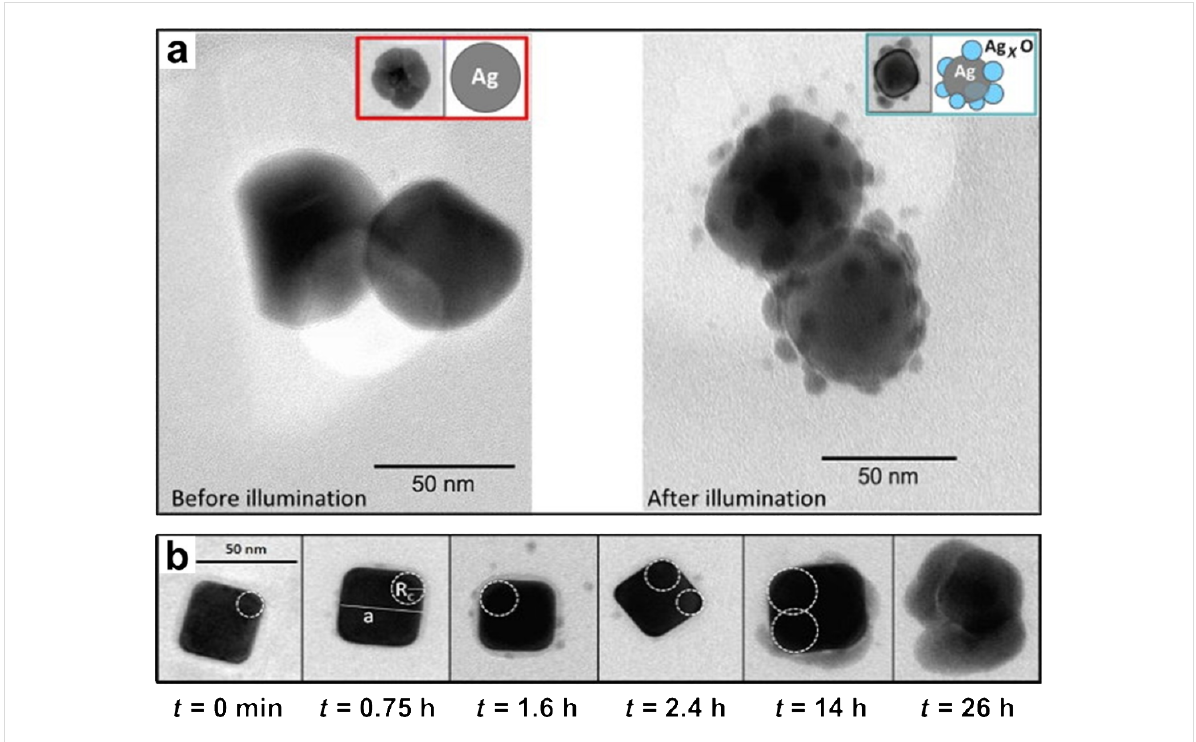
Figure 4: (a) Comparative TEM micrographs of spherical AgNPs before (left) and after (right) light irradiation. The formation of small NPs (Ag x O) after light irradiation is indicative of photo-oxidation. (b) TEM micrographs representing the cubic AgNPs that were continuously irradiated with light for t = 0 min, 45 min, 1.6 h, 2.4 h, 14 h, and 26 h, respectively. Reprinted with permission from [52], Copyright 2013 American Chemical